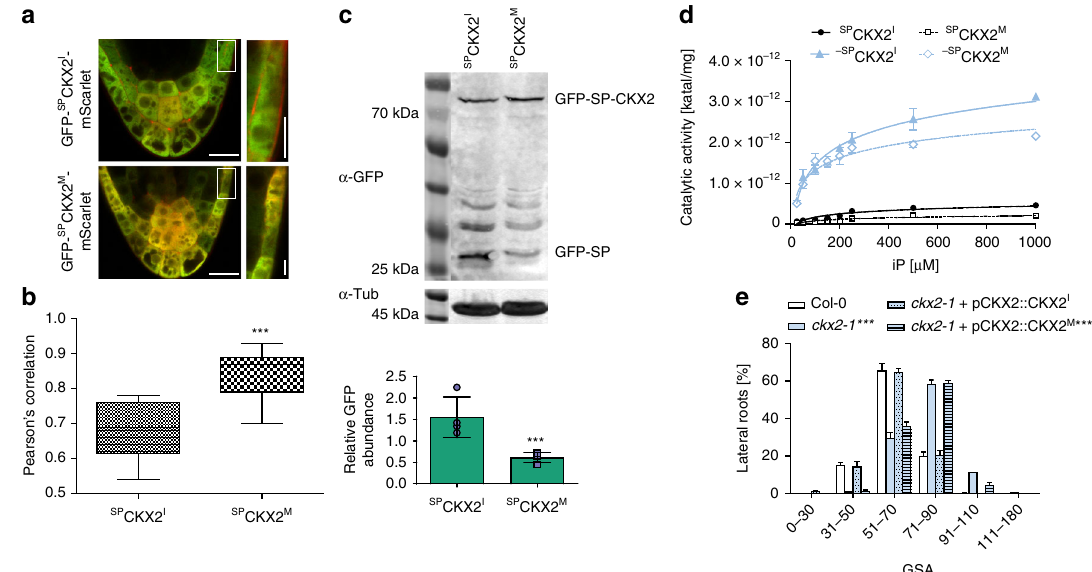
Fig. 5 Signal peptide processing is required for CKX2 activity. a Localization of GFP- SP CKX2 I -mScarlet and GFP- SP CKX2 M -mScarlet in stage II LRs. Scale bar, 25 and 10 µ m, respectively. b Quanti fi cation of the co-localization of GFP and mScarlet signal using Pearson ’ s correlation. Horizontal lines show the medians; box limits indicate the 25th and 75th percentiles; whiskers extend to the min and max values. Student ’ s t -test P -Value: *** P < 0.001, n = 10 – 12 individual LRs. c Immunoblot analysis and quanti fi cation of SP CKX2 I and SP CKX2 M expressed in N. benthamiana leaves using anti-GFP antibody. Anti-tubulin antibody was used as loading control. The signal of GFP-SP was quanti fi ed and normalized to tubulin. Student ’ s t -test P -Value: *** P < 0.001. Mean± SEM, n = 4 biological replicates. d Saturation curves of isopentenyladenine (iP) degradation by CKX2. Reactions were performed at pH 7.4 in McIlvaine buffer with 0.5 mM DCIP as electron acceptor (black fi lled circle SP CKX2 I , white square SP CKX2 M , black fi lled triangle SP CKX2 I , white diamond -SP CKX2 M ). Mean ± SEM, n = 8. e GSA distributions of ckx2-1 was complemented by pCKX2::CKX2I, but not by pCKX2::CKX2M. Representative lines are shown. Kolmogorov – Smirnov test P -value: *** P < 0.001 (compared to Col-0 ). Mean ± SEM, n = 5 plates (16 seedlings with 65 – 160 LRs per plate). a – e Experiments were repeated at least three